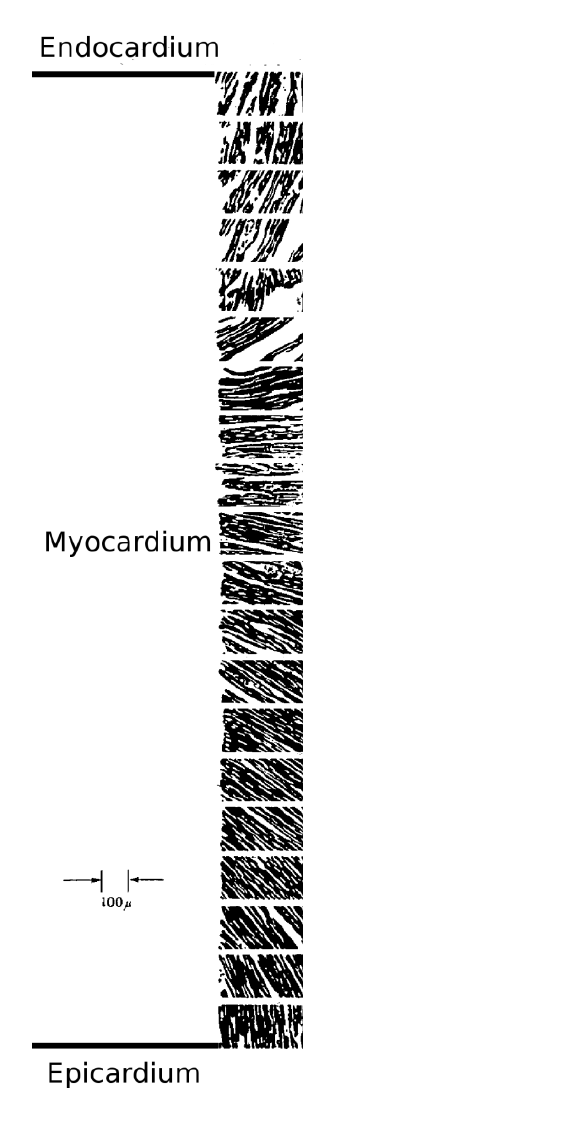
Figure 2. Frank-Starling law for mechanical behaviors of the ventricle muscle